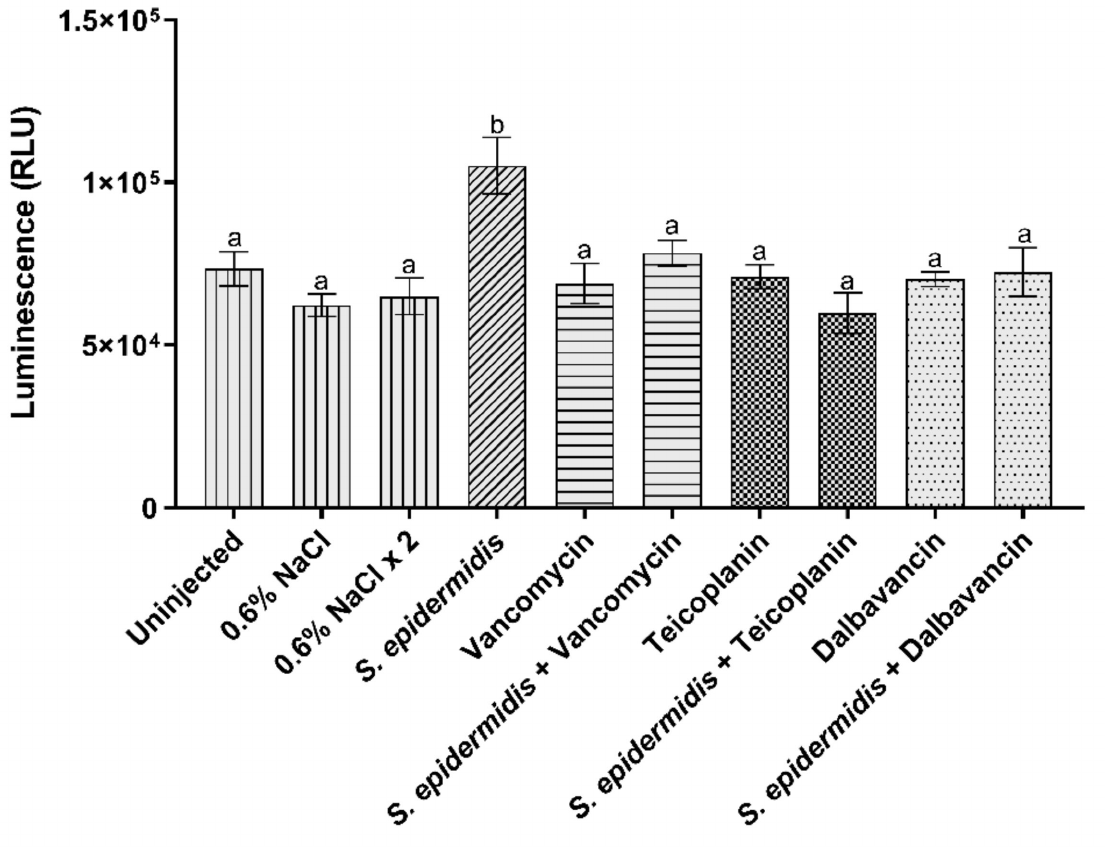
Figure 3. Hemocytes activity detected using a luminescence assay. Values represent mean ± s.e.m. Different letters indicate statistically significant differences among treatments ( p <